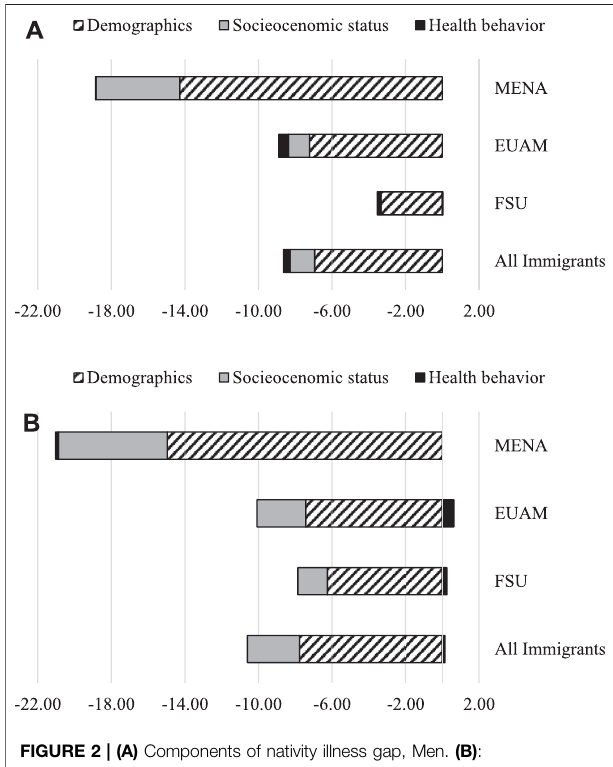
FIGURE 2 | (A) Components of nativity illness gap, Men. (B) : Components of nativity illness gap, Women.